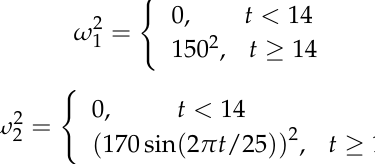
( d ) Figure 5. System states in the presence of faults: ( a ) Roll angle, ( b ) Pitch angle, ( c ) Yaw angle, and ( d ) z-direction.